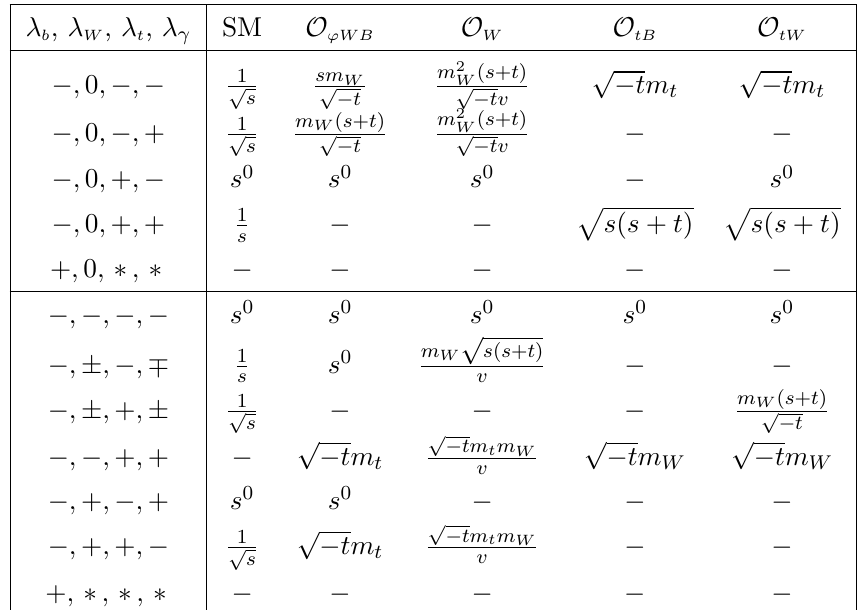
Table 11. Helicity amplitudes in the high-energy limit ( s Overall multiplicative factors are dropped and only the schematic energy dependence is retained for the SM contribution. Helicity entries marked by ‘ section 4.1.1 for a discussion of the results.